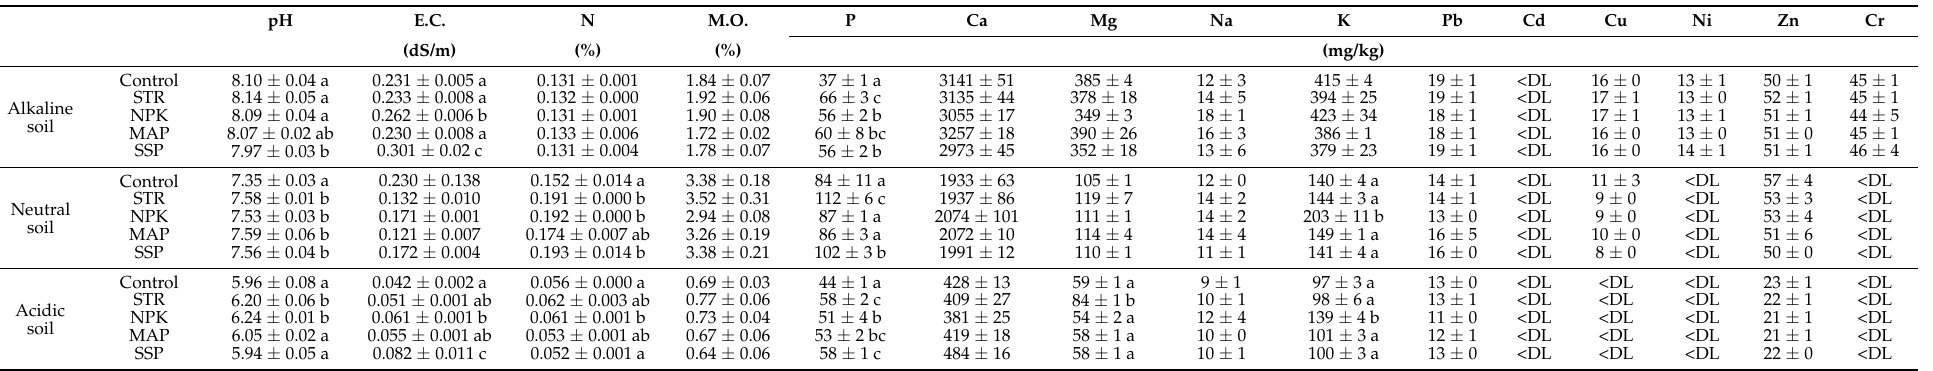
Table 5. Physicochemical characteristics of soils after leaching assay. Values followed by different letters indicate significant differences ( p < 0.05, Duncan’s test). DL: detection